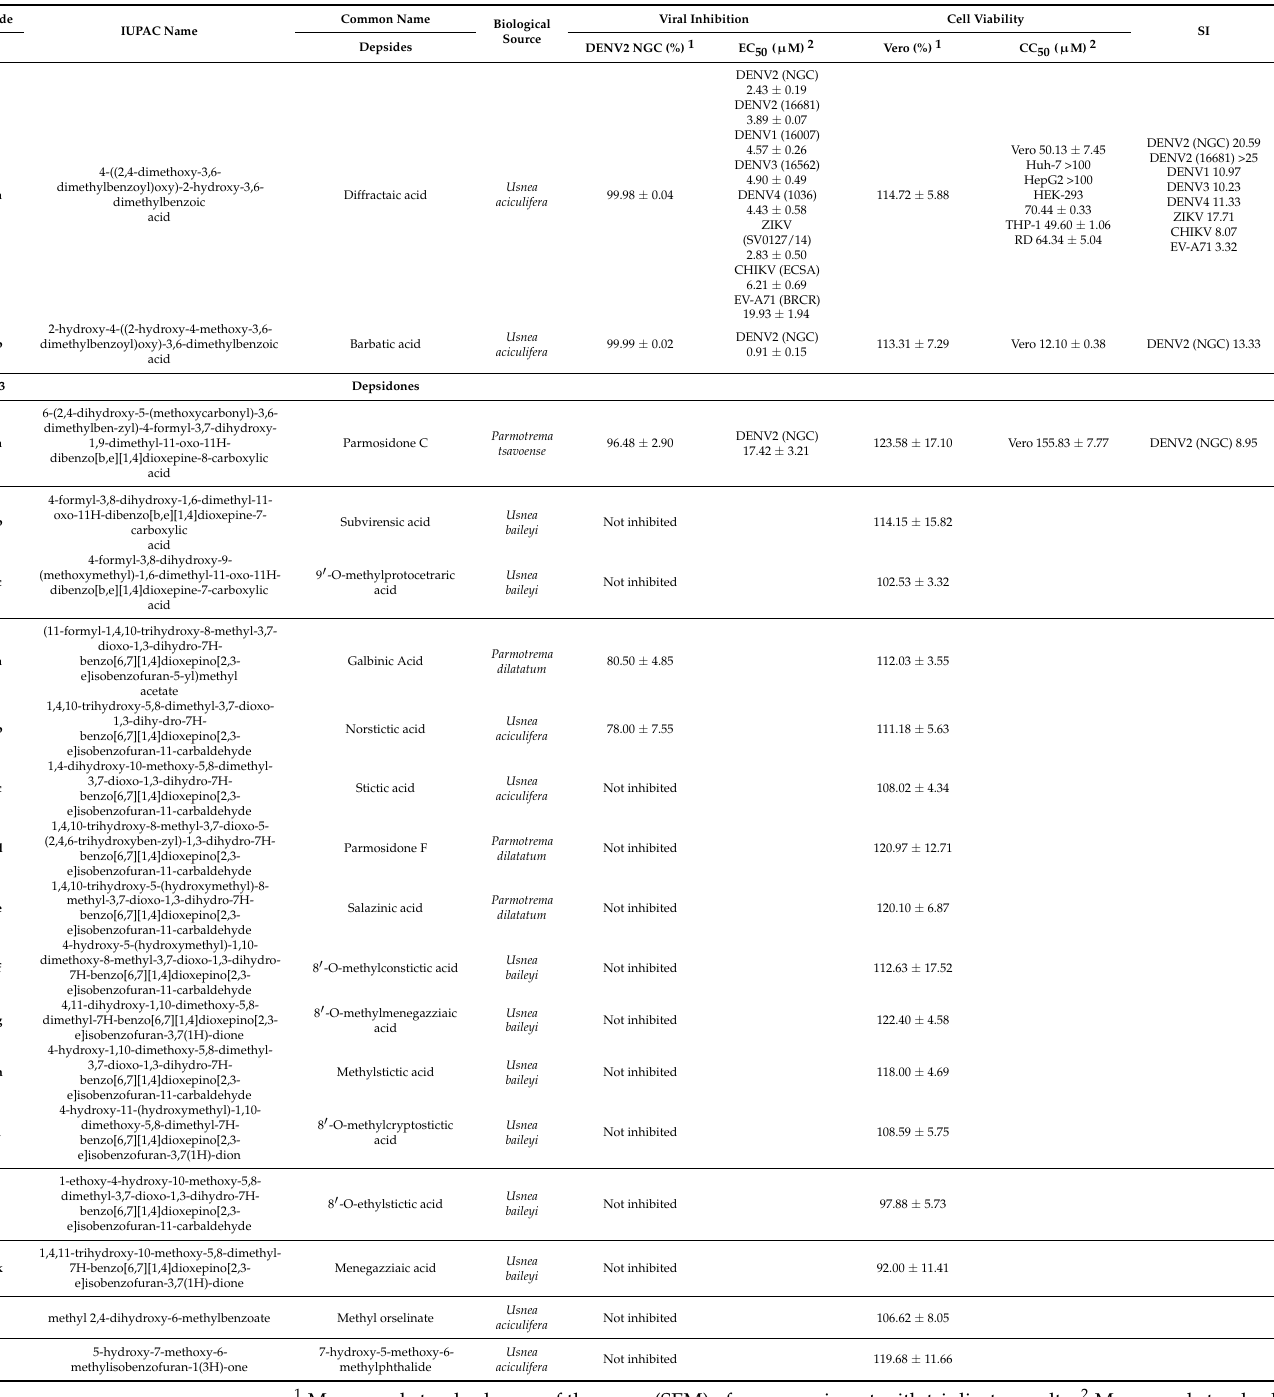
1 Means and standard error of the mean (SEM) of one experiment with triplicate results. 2 Means and standard error of the mean (SEM) of three independent experiments. 2.3. Diffractaic Acid Inhibits DENV2 after Entry and Interferes with Viral Replication The molecular target of diffractaic acid was screened using a time-of-addition assay with low viral titer to initially determine whether the target resides at early or late time- points. Diffractaic acid at 10 µ M was added to DENV2-infected Vero cells (MOI of 0.1) at various timepoints (0, 2, 4, 6, 8, 10, 12, 24, 36, 48, 60, and 72 h post infection) (Figure 2A). DMSO was used as a control without inhibition. After 72 h, the supernatants were